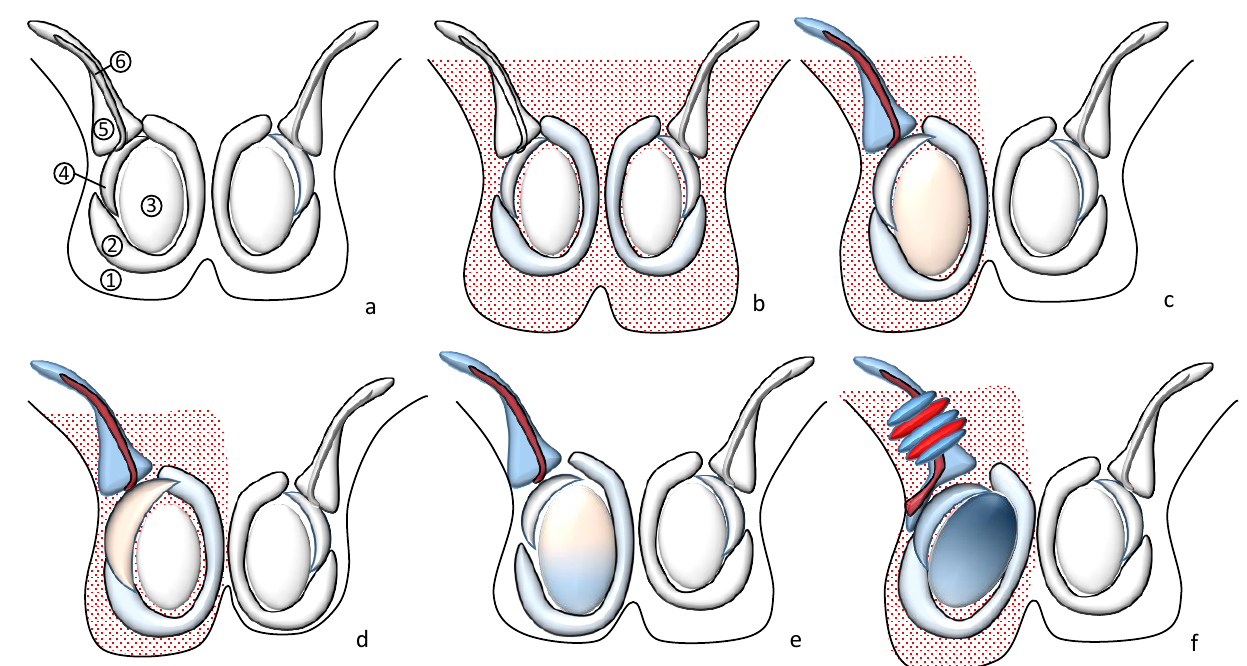
Figure 3. Scrotal involvement in Henoch – Schönlein syndrome. ( a ) Schematic representation of the normal scrotal anatomy: scrotal wall (1), tunica vaginalis (2), testicle (3), epididymis (4), pampiniform plexus (5), spermatic artery (6). ( b ) Scrotal skin inflammation: bilateral thickening and swelling of the scrotal wall, small bilateral hydroceles, normal testes. ( c ) Orchitis: increased testicular volume and blood flow, often thickening of the scrotal wall, hydrocele, and funiculitis. ( d ) Epididymitis: increased epididymal volume and blood flow, often thickening of the scrotal wall, hydrocele, and funiculitis. ( e ) Primary vascular testicular damage: increased testicular volume, focal or diffuse decrease/absence of testicular blood flow, absent twisting of the spermatic cord. ( f ) Testicular torsion: twisting of the spermatic cord, redundant spermatic cord in the scrotal sac, rotated testis, increased volume, decrease in/absence of testicular blood flow, sometimes hydrocele and thickening of the scrotal wall.